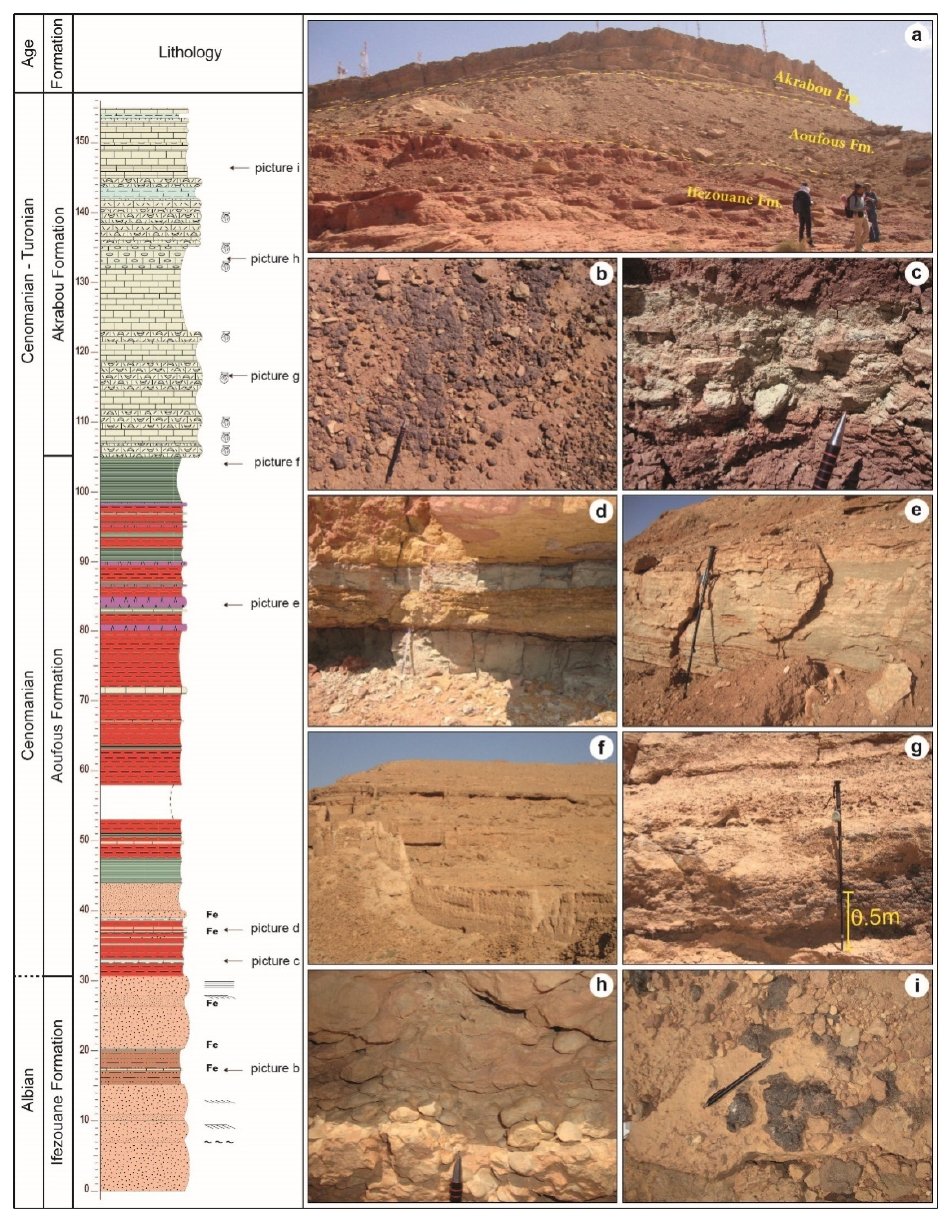
Figure 7. Goulmima section. ( a ) general view of the series; ( b ) a ferruginous surface on the top of a sandstone bed of the Ifezouane Formation; ( c ) alternating red clays and green marls with centimetric limestone beds; ( d ) alternation of sandstone and limestone levels with a blackish clayey drape; ( e ) a metric bed of primary gypsum; ( f ) panoramic picture of the Cenomanian–Turonian unit; ( g ) lumachellic limestones with silicified shells; ( h ) nodular limestone level; ( i ) surface with concentrations of silicified shells.